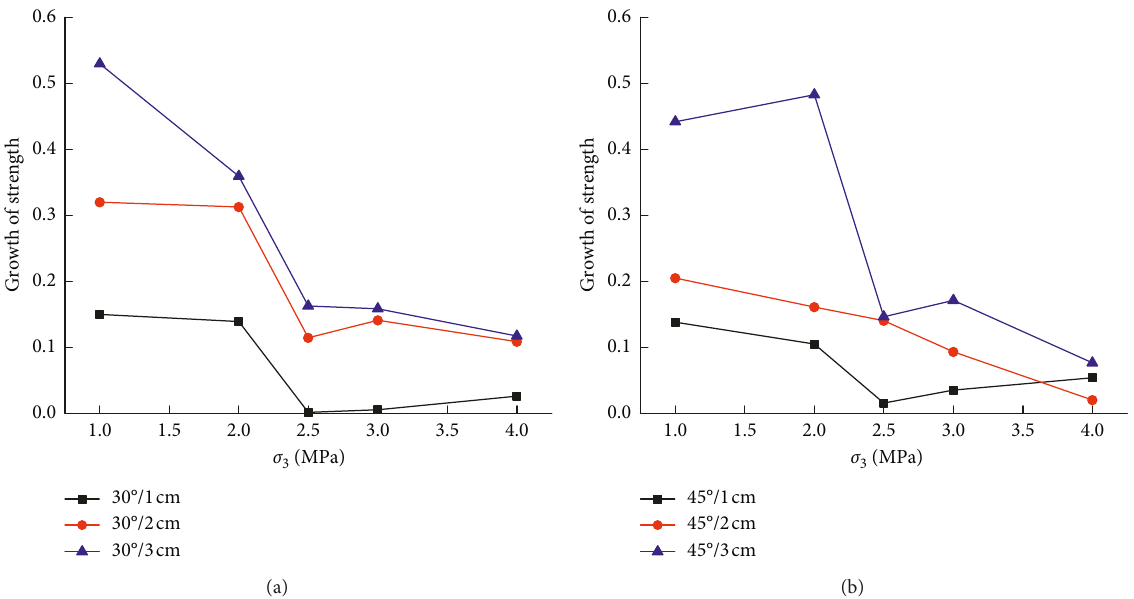
Figure 12: Growth rate of the strength of the specimens having different flaw lengths under different confining pressures when the flaw inclination angle is (a) 30 ° and (b) 45 ° .